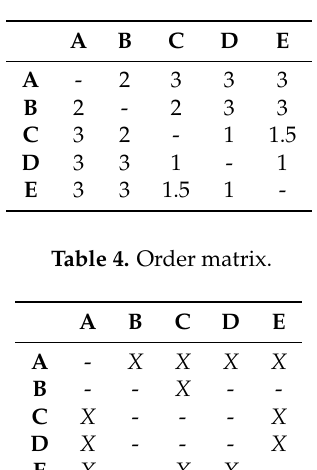
Table 3. Time matrix.